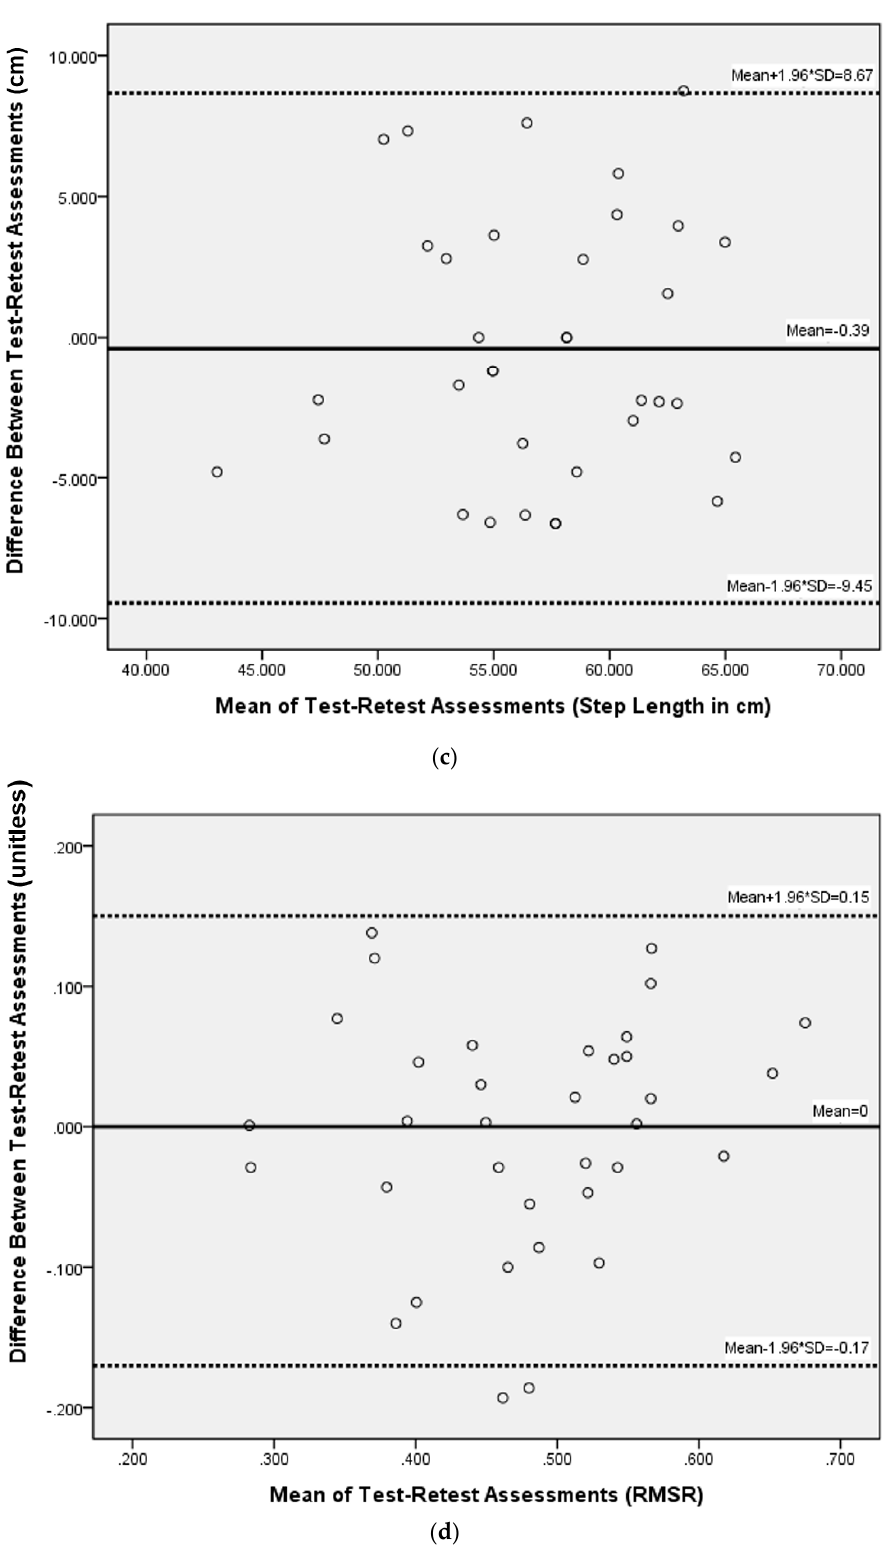
Figure 6. Bland-Altman method for plotting the differences in measures between the two walking tests against the corresponding mean of that measure for ( a ) walking speed, ( b ) cadence, ( c ) step length, and ( d ) acceleration RMSR in the medial-lateral direction. RMSR, root mean square ratio.